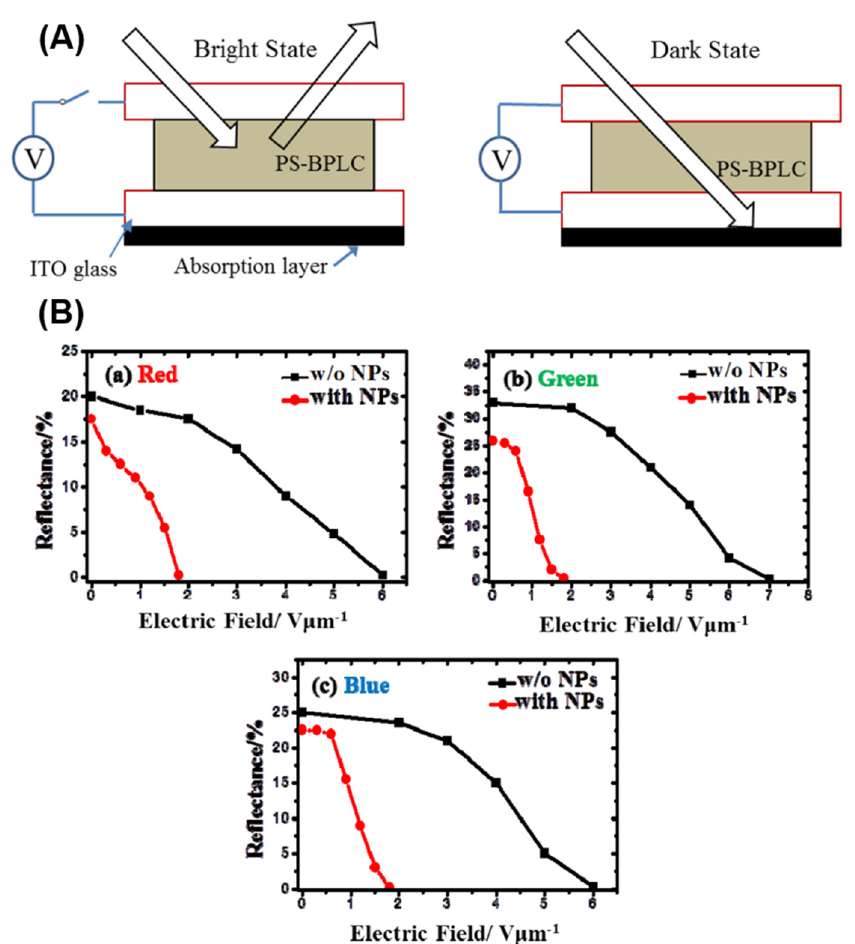
Figure 5. ( A ) Working principle of the proposed reflective display, ( B ) relationships of reflectance and driving electric field with and without doping BaTiO 3 ferroelectric nanoparticle [71]. Low voltage polymer-stabilized blue phase liquid crystal reflective display by doping ferroelectric nanoparticles from Luo, Opt Express; published by OPTICAL SOC AMER.